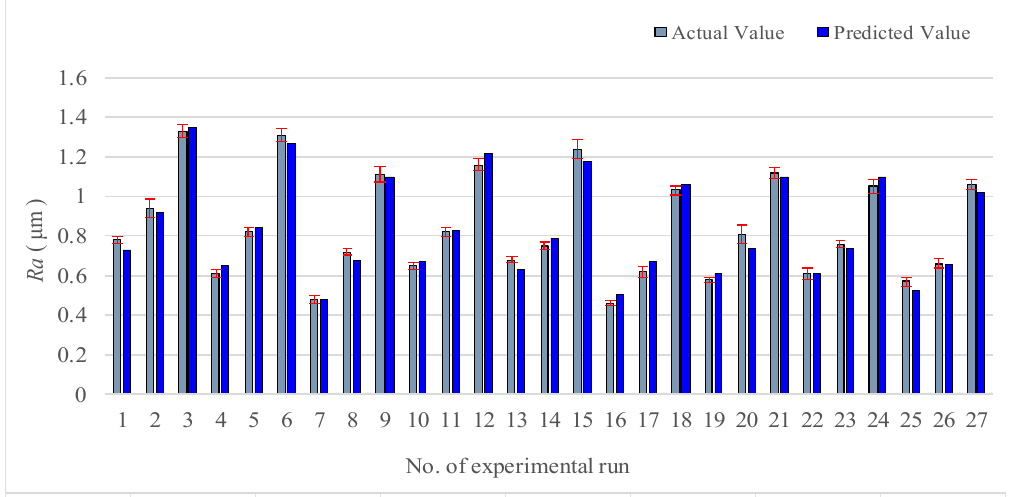
Figure 7. Comparison chart between predicted value and measured value (Ra).